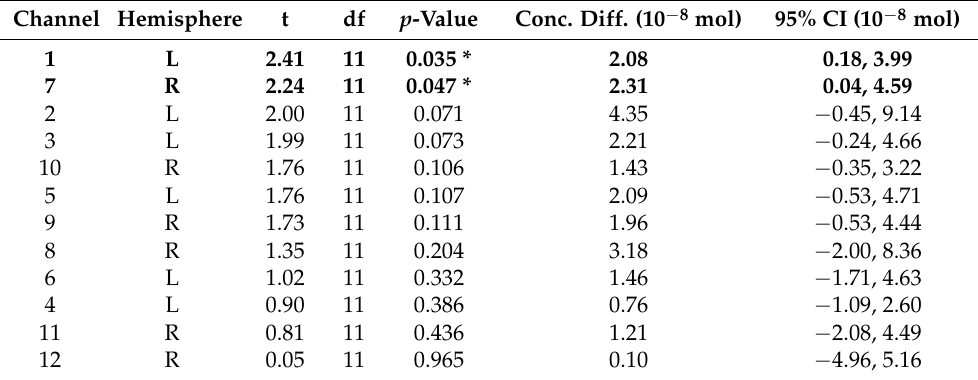
Table 2. Per-channel HbR average concentration differences between nGVS and sham stimulation. Channels are ordered according to their p values.